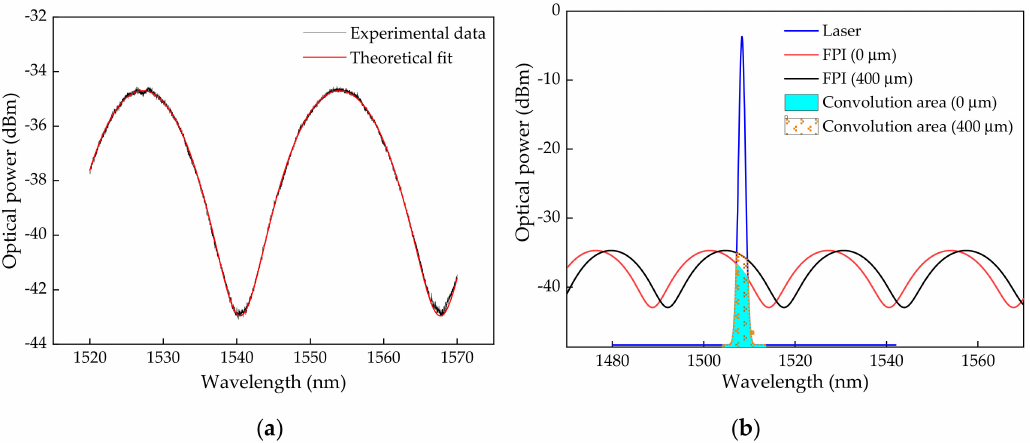
Figure 3. ( a ) Produced FPI transfer function and the correspondent fit to Equation (1); ( b ) Illustration of the laser and FPI convolution integrated area variation with an increased